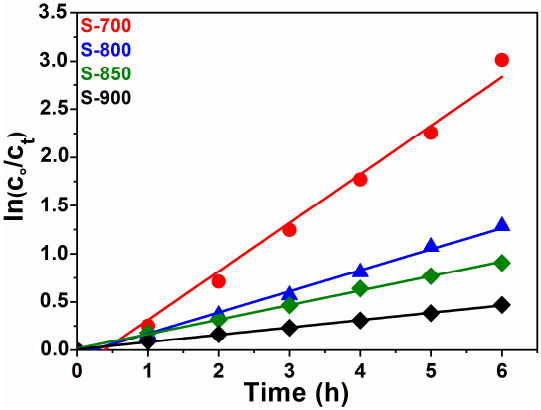
Figure 10. Kinetics curves of LaFeO 3 perovskites calcined at different temperatures.